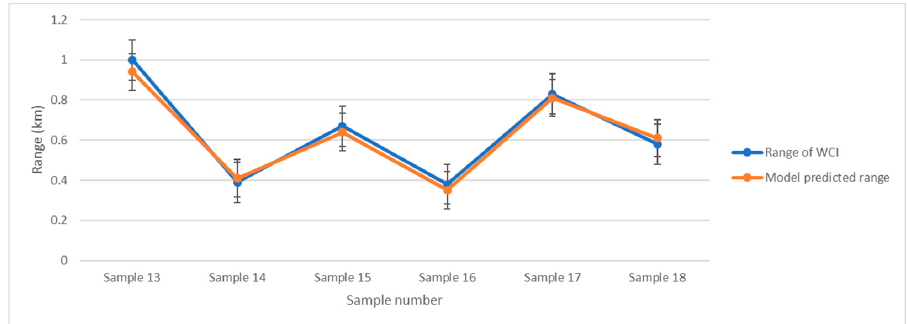
Figure 5. L Regression model validation of WCI range by estimating the other 6 samples.